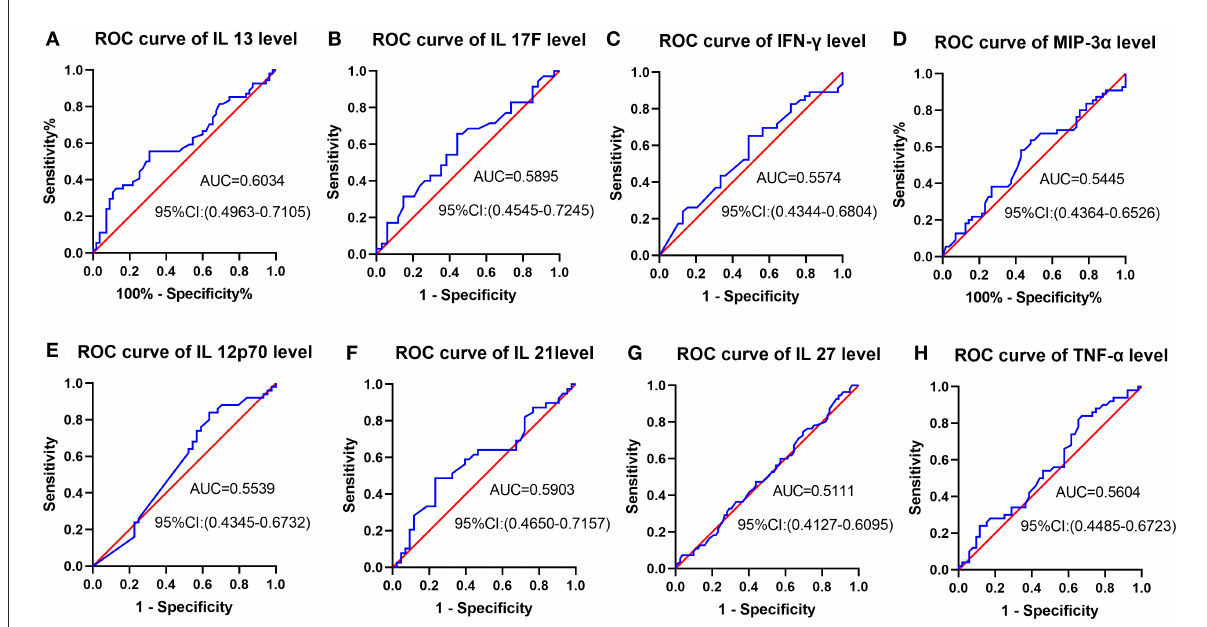
FIGURE3 ROC analysis of cytokines as a predictor for post-stroke cognitive recovery improvement. (A–H) AUC is from 0.5111 to 0.6034, suggesting a low accuracy of prediction.